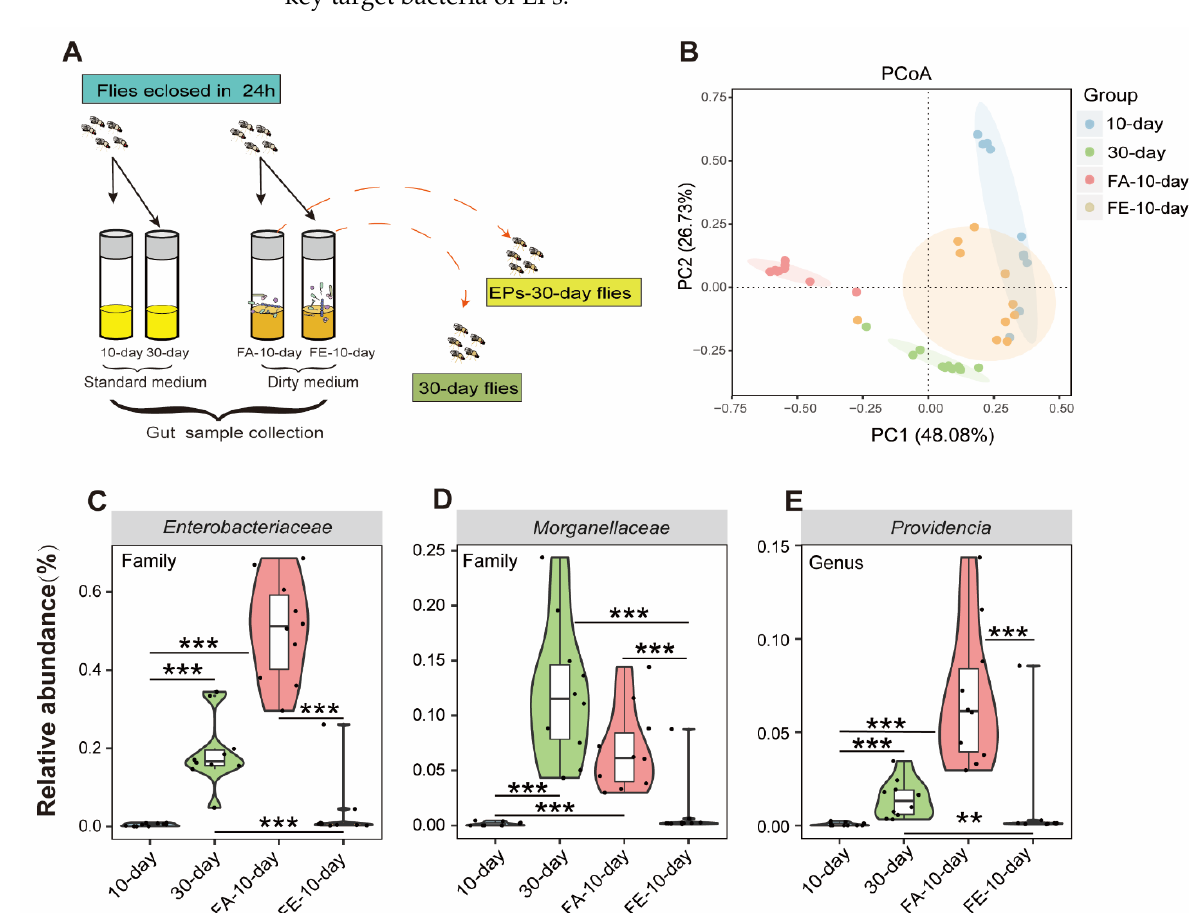
Figure 7. FMT from old flies fed with or without EPs differently affected the gut microbiota in young flies. ( A ) Schematic diagram of the experimental procedure. ( B ) ASV-based PCoA with Bray–Curtis distance (for principal component 1 and principal component 2) showed variations in the gut microbial beta diversity of 10-day-old, 30-day-old, FA-10-day (flies cultured on the dirty medium from 30-day-old flies in the control group for 10 days), and FE-10-day (flies cultured on the dirty medium from 30-day-old flies in the EP groups for 10 days) and assessed with PERMANOVA. ( C–E ) Relative abundance comparison of Gluconobacter ( C ), Providencia ( D ), and Enterobacteriaceae ( E ) in the gut microbiota of 10-day-old, 30-day-old, FA-10-day, and FE-10-day flies detected with 16S sequencing analysis. ** p < 0.01, *** p <